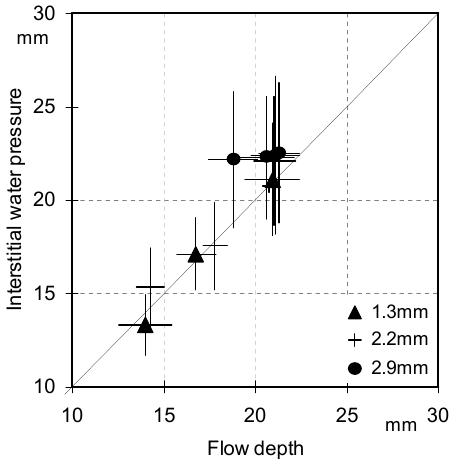
Fig. 6. Relationship between flow depth and interstitial water pressure. Mean values and standard deviations are shown. The solid line indicates the hydrostatic pressure.